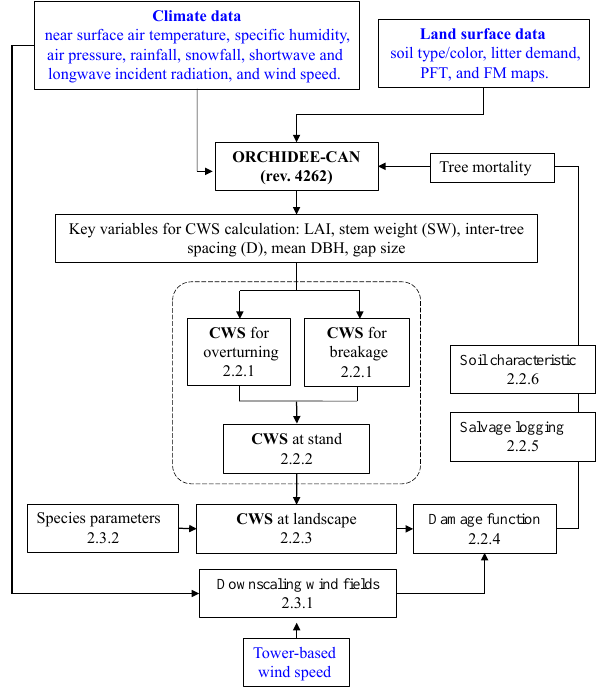
Figure 1. Information flow of this study showing the link between the different elements presented in Sects. 2.2 and 2.3 (numbers in the figure refer to section numbers in the text). The diagram shows input data in blue. The dashed box shows critical wind speed calcu- lations according to